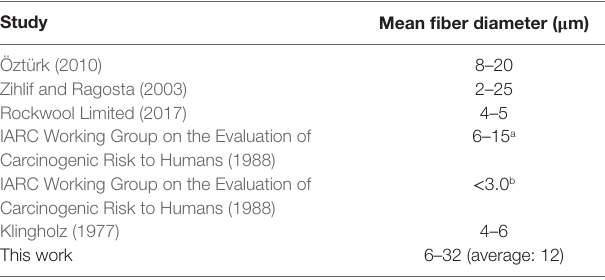
TaBle 1 | Details of the mean fiber length of silicate insulation materials obtained from prior studies on their physical form (and in some instances, elemental